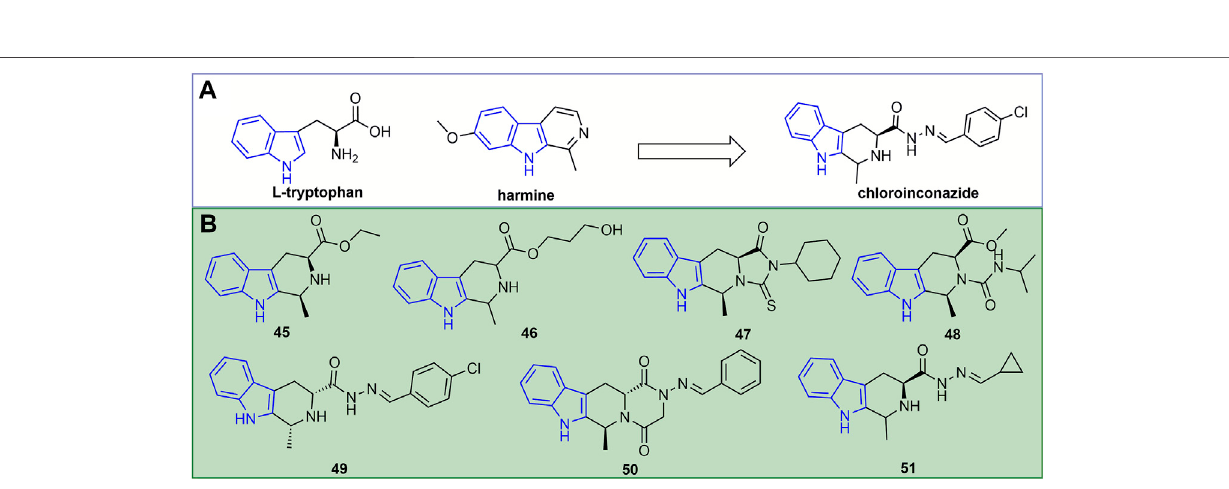
Frontiers in Chemistry |